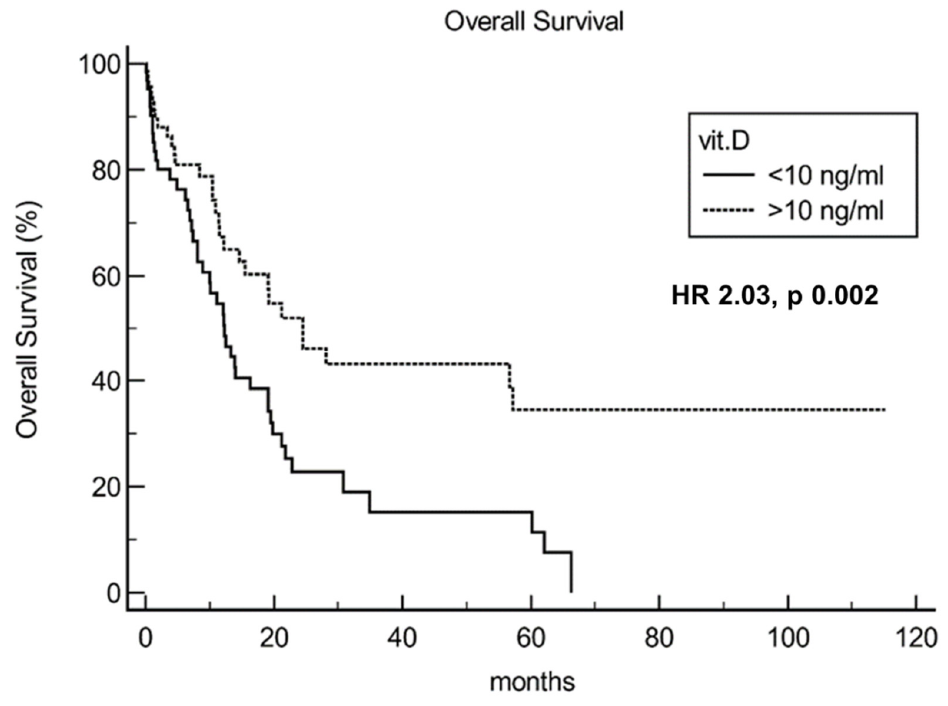
Figure 2. Survival analysis evidenced different survival according to vitamin level (< vs. >10 ng/dL). Vit.D: vitamin D.